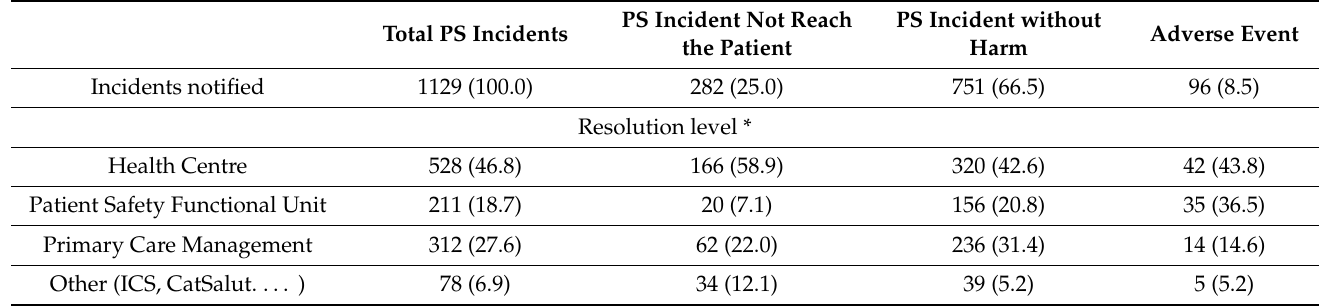
Table 4. Distribution of the type of incidents reported according to the resolution level.